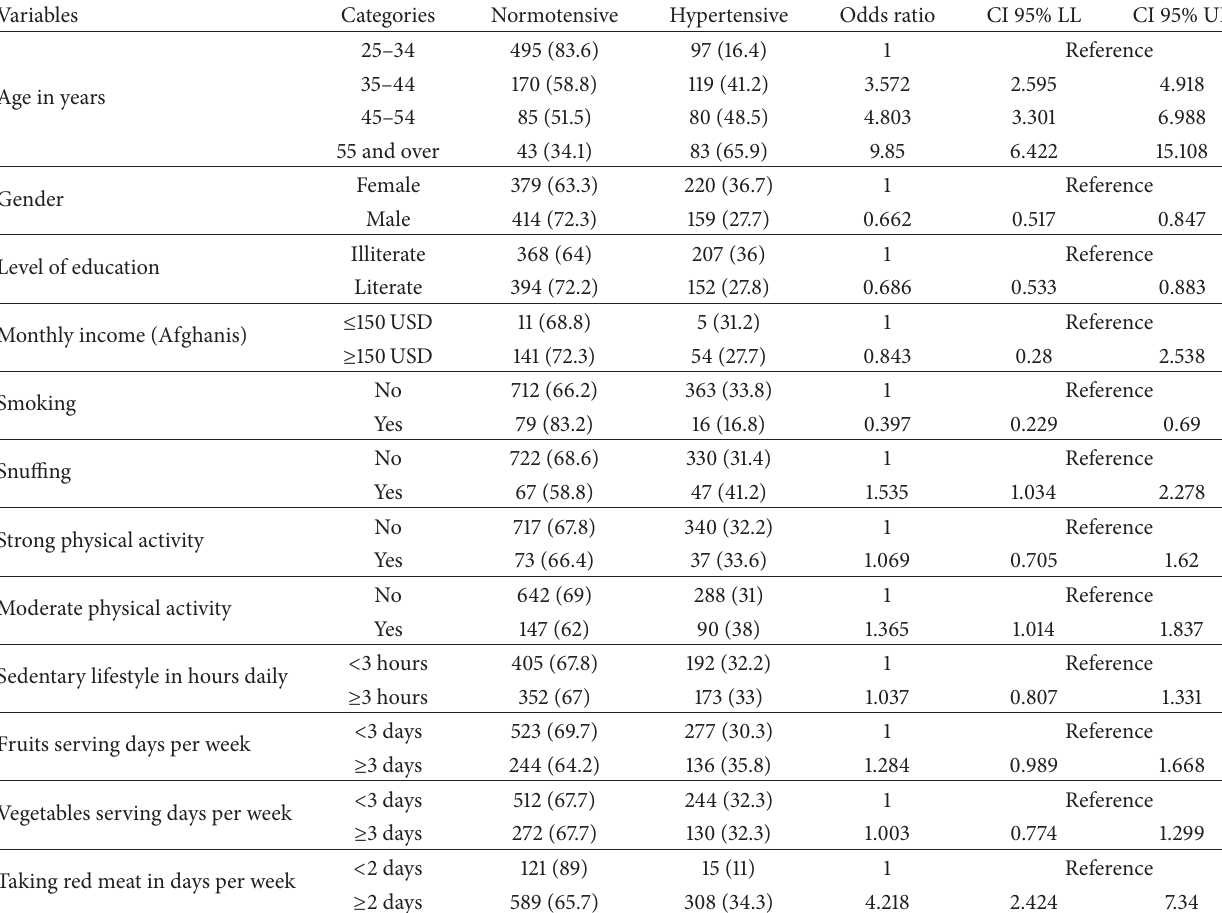
Table 3: Bivariate analysis of biodemographic and socioeconomic factors and hypertension among study participants in Kabul,